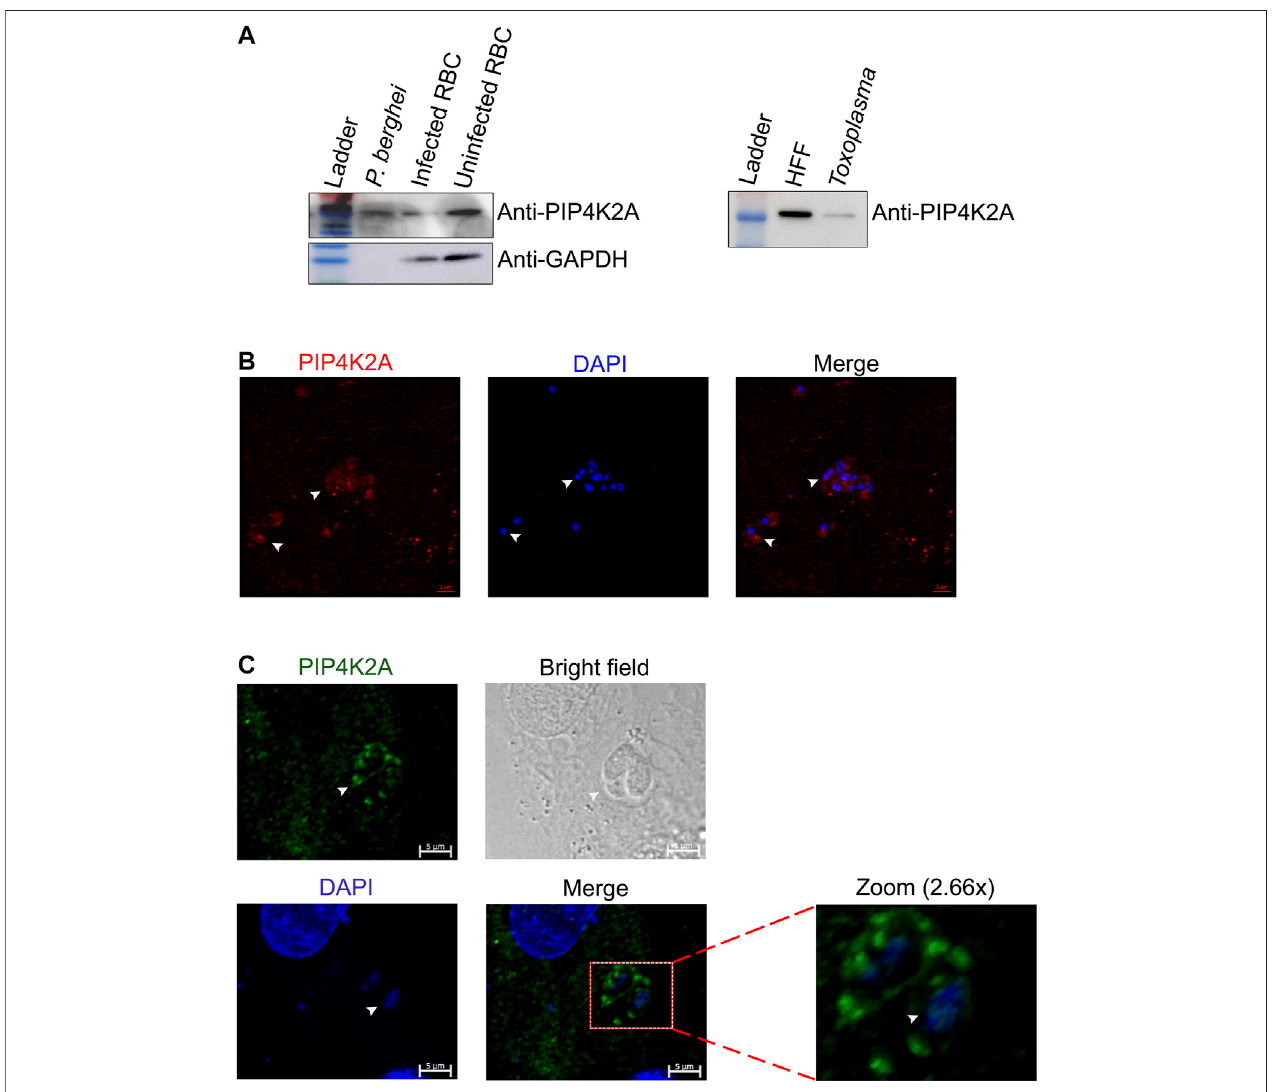
FIGURE2| TheimportofPIP4K2Afromahostcellisconserved inotherapicomplexafamily members. (A) .RBClysateand isolatedpuri fi ed P.berghei lysate were resolved on 10% SDS PAGE and probed with anti-PIP4K2A (left top panel), and anti-GAPDH (left lower panel). Human foreskin fi broblast cell (HFF) lysate and puri fi ed toxoplasma parasite lysate were resolved on 10% SDS PAGE and probed with anti- PIP4K2A (right panel) ( n (cid:1) 3). (B) Immunostaining of puri fi ed P. berghei using anti- PIP4K2A {ab154585 (in red)} and DAPI (in blue). The parasite is indicated by arrows. (C) Immunostaining of HFFs infected with toxoplasma using anti-PIP4K2A {(sc100406 (in green)} and DAPI (in blue) ( n (cid:1) 3). The arrows indicate the parasite.